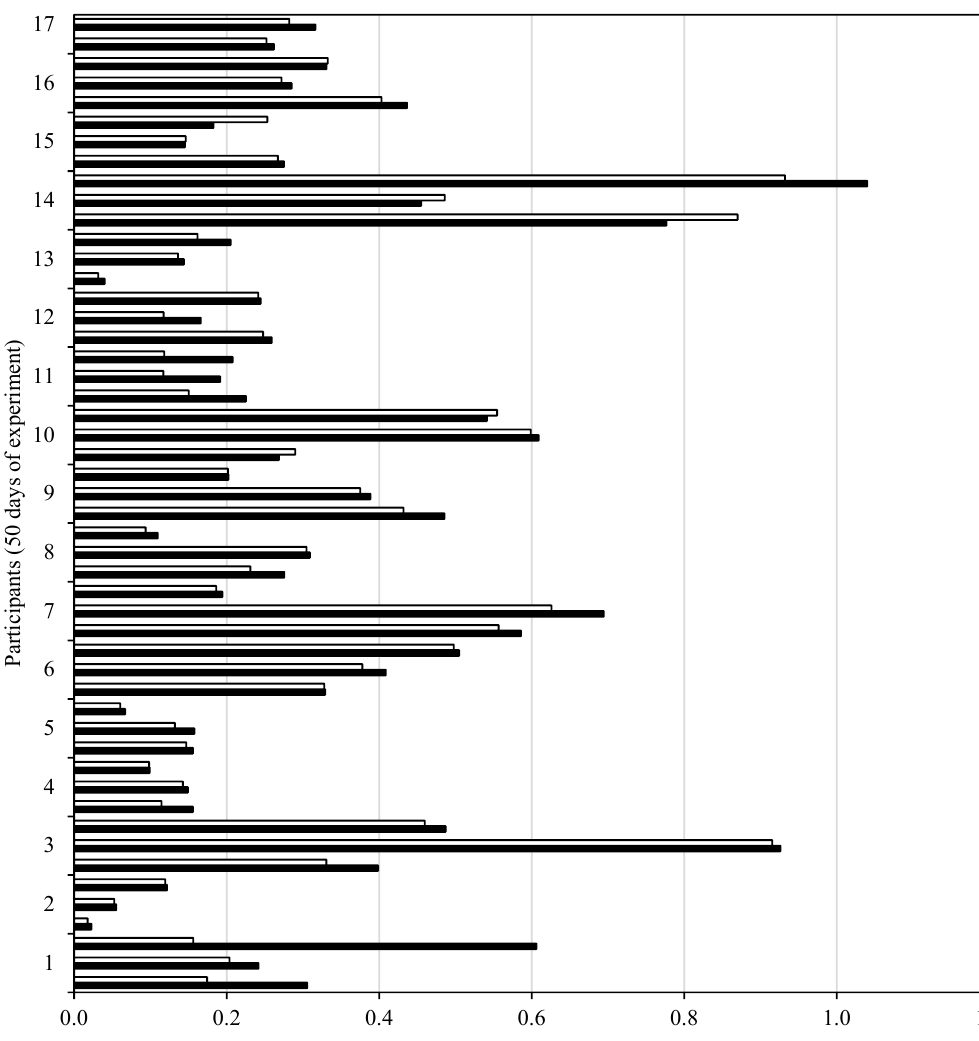
Figure 9. Static and dynamic exposure measures of traffic-related PM 2.5 concentrations (µg/m 3 ).